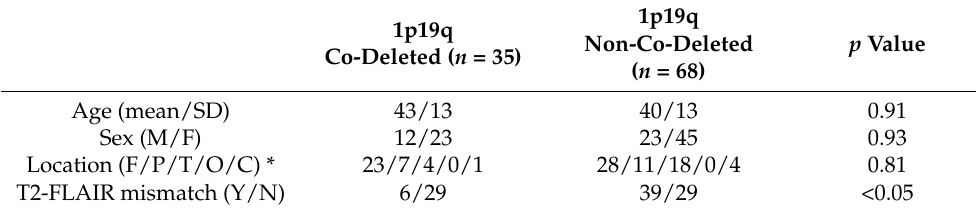
Table 1. Demographic information for study